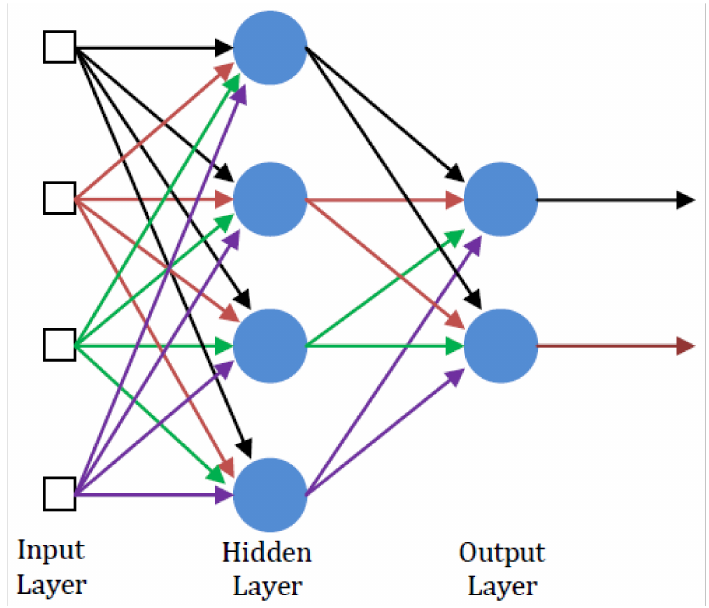
Figure 5. The multilayer feedforward network.